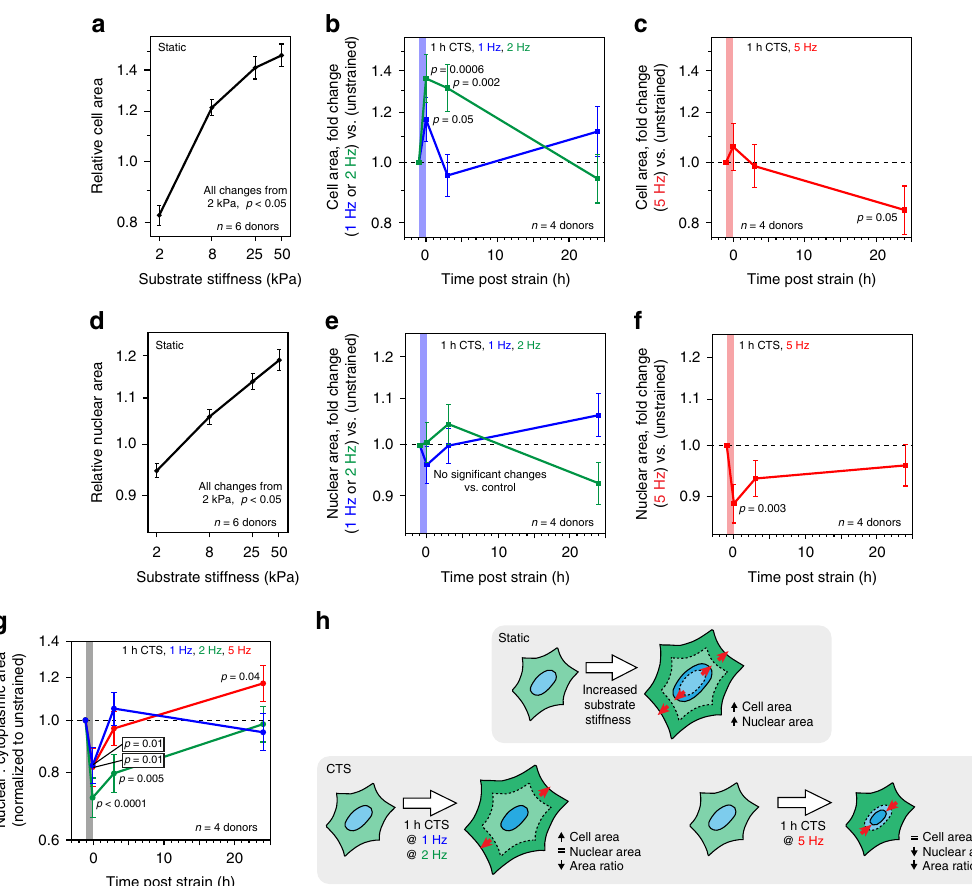
Fig. 1 Coupled cell and nuclear morphologies are lost following cyclic tensile strain (CTS). a Relative areas of primary human mesenchymal stem cells (hMSCs) cultured on static substrates (collagen-I coated polyacrylamide hydrogels; 2 – 50 kPa; n = 6 donors), showing increase with substrate stiffness ( p < 0.05). b Cell areas of hMSCs following low-intensity CTS (0 – 4% strain at 1 or 2 Hz for 1 h; n = 4 donors). Areas increased immediately following strain (1 Hz, p = 0.05; 2 Hz, p = 0.0006 and p = 0.002 at 3 h). c Cell areas of hMSCs following high-intensity CTS (2.6 – 6.2% strain at 5 Hz for 1 h; n = 4 donors), showing decreased 24 h post strain ( p = 0.05). d Relative nuclear areas of hMSCs cultured on static substrates (collagen-I coated PA hydrogels; 2 – 50 kPa; n = 6 donors). Nuclear areas increased with substrate stiffness ( p < 0.05). e Nuclear areas of hMSCs after low-intensity CTS (0 – 4% strain at 1 or 2 Hz for 1 h; n = 4 donors). f Nuclear areas of hMSCs cultured following high-intensity CTS (2.6 – 6.2% strain at 5 Hz for 1 h; n = 4 donors). Nuclear areas decreased immediately following strain treatment ( p = 0.003). g Nuclear to cytoplasmic area ratio of hMSCs following CTS (1 h; 0 – 4% strain at 1 or 2 Hz or 2.6 – 6.2% strain at 5 Hz; n = 4 donors). Area ratios decreased immediately following strain treatment for all CTS frequencies (1 Hz, p = 0.01; 2 Hz, p < 0.0001; 5 Hz, p = 0.01). Only the 5 Hz treatment group showed an increased ratio at 24 h (5 Hz, p = 0.04). All CTS experiments normalized to unstrained controls; data displayed as mean ± s.e.m.; p -values determined from ANOVA. See Supplementary Fig. 1a – c, f for example cell images and donor-to-donor variability; Supplementary Table 1 for sample sizes. h In summary, cell and nuclear areas appeared coupled on increasingly stiff substrates. Low-intensity CTS increased cell area, but did not change nuclear area; high-intensity CTS caused nuclear area to decrease independently of cell endothelial progenitor cells subjected to low frequency (0.1 Hz) strain cycling 34 . The distribution of changes to gene expression was narrowed 24 h after CTS (Gaussian width = 0.14; Supple- mentary Fig. 4a).